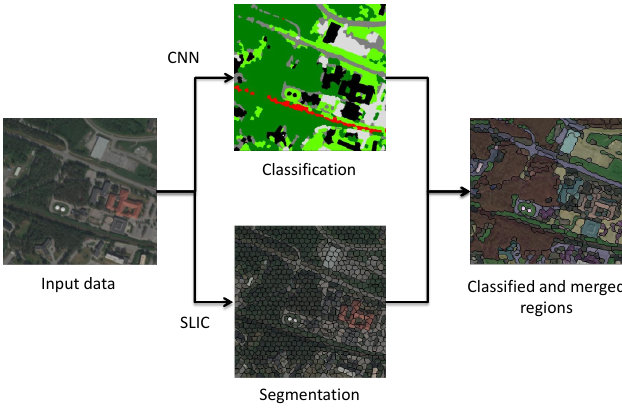
Figure 5. Merged classified regions are obtained by averaging the classification results (Black = building, Dark Green = Vegetation, Light Green = Ground, Gray = Road, Red: RailRoad) over all classified pixels in each region from an initial SLIC segmentation. Regions are merged if the average classification certainties for two connecting regions are both above a certain